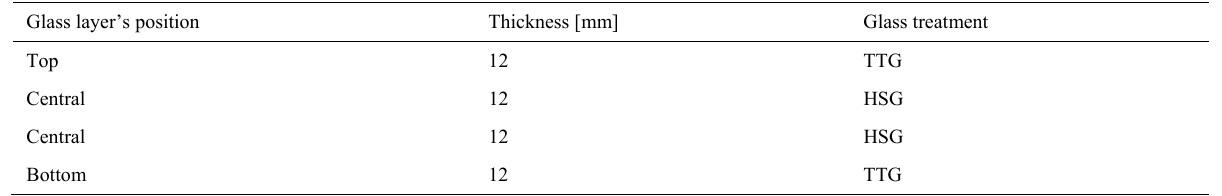
Table 2: Composition of the laminated floor glass slab.